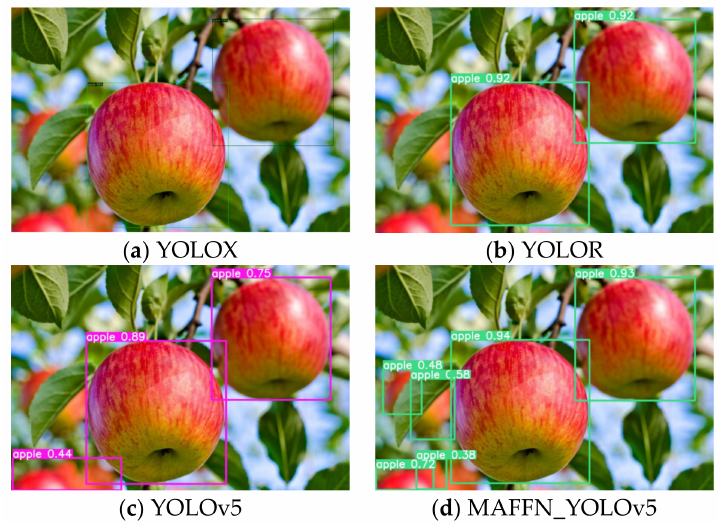
Figure 30. Results of the ablation study for the apple